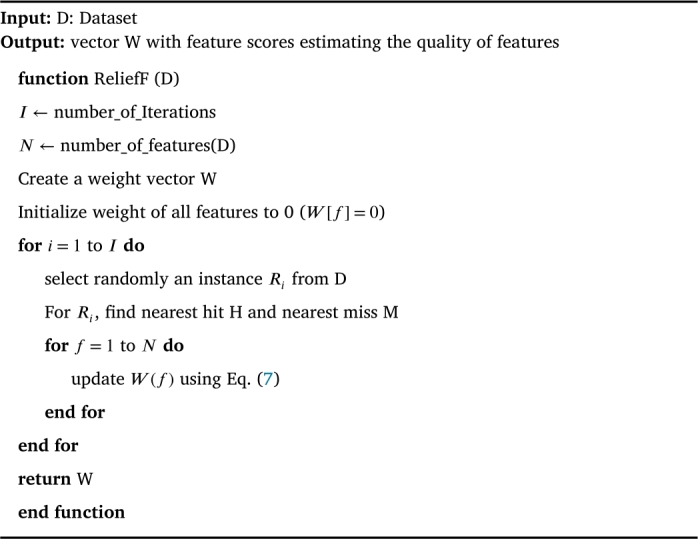
ReliefF Algorithm [35].